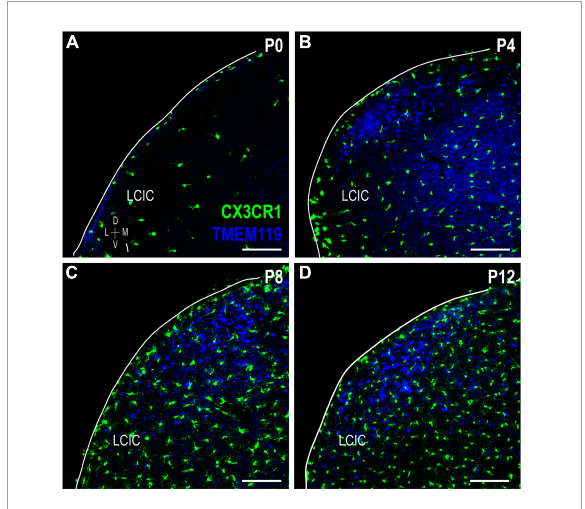
FIGURE8 Transmembrane protein (TMEM119) expression (blue) in a developmental series (A–D) of fractalkine receptor (CX3CR1)-GFP (green) mice. Lateral cortex of the inferior colliculus (LCIC) TMEM119 expression is absent at birth (a) and then largely localized to layer 2 after its appearance at P4 (B–D) . Aside from rare double-labeled cells seen at P12 ( data not shown ), no co-localization was observed. Scale bars = 100 µ